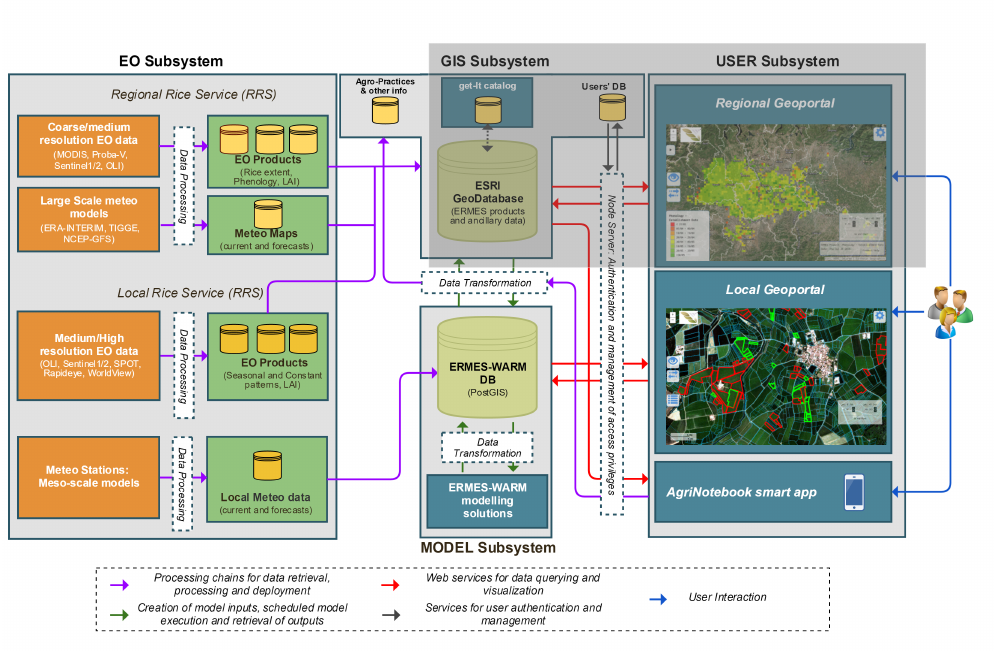
Figure 1. Overall conceptual architecture of the ecosystem of the Earth obseRvation Model-based ricE information Service (ERMES) tools (updated from Busetto et al. [32]). The shadow rectangle denotes the focus of this paper. EO: Earth observation; GIS: geographic information systems; MODIS: moderate resolution imaging spectroradiometer; WARM: Water Accounting Rice Model; LAI: leaf area